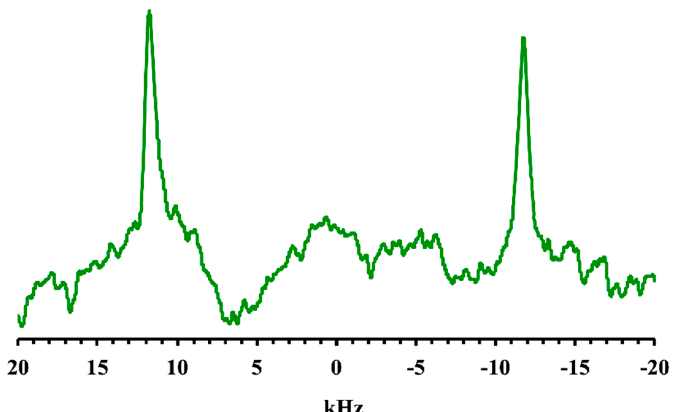
Figure 2. 14 N-NMR spectrum of SDS / CTAB aqueous solution ( R = 1.5 sample).